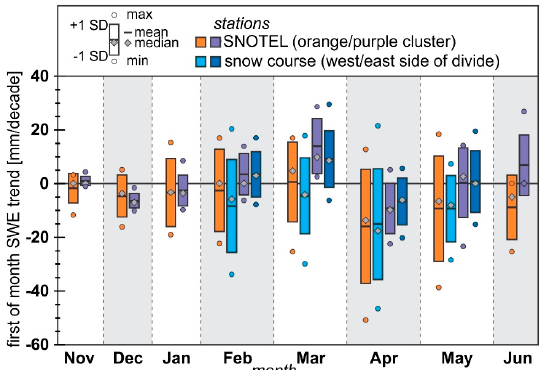
Figure 2. Distribution of monthly trends in snow water equivalent (SWE) on the first of each month with data for west and east station groupings: Snowpack Telemetry (SNOTEL) stations [15] and snow courses (orange and purple groups), for the period from 1981 to 2015.